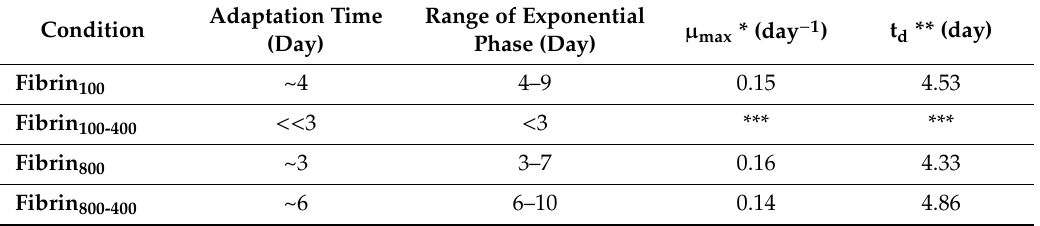
Table1. Kineticparametersforh-AdMSCproliferationseededinthefibrinnetworksoftheL-PRPpreparations.